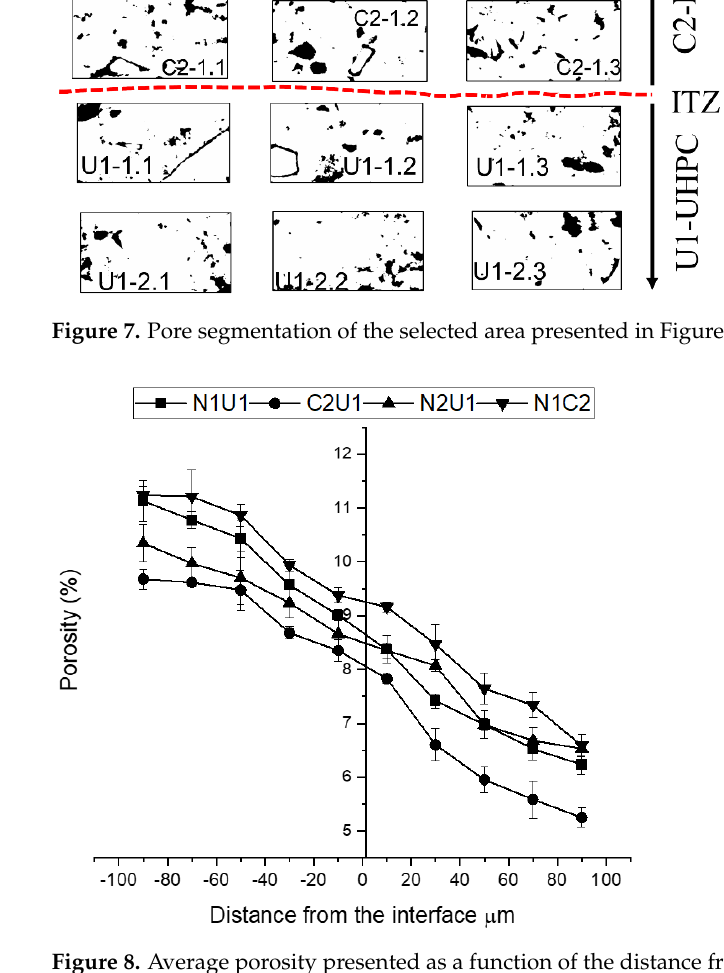
Figure 8 . Average porosity presented as a function of the distance from the ITZ .